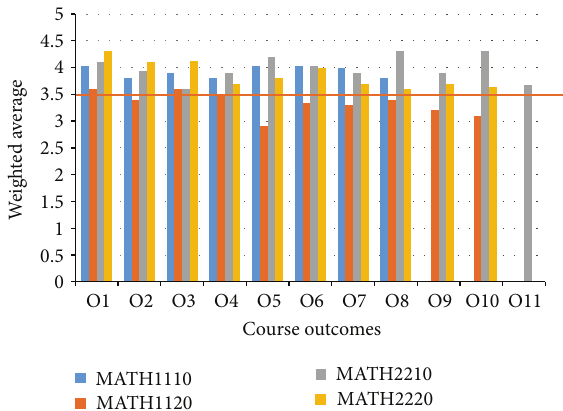
Figure 1: The average level of satisfaction of the course outcomes over three semesters for all math courses.